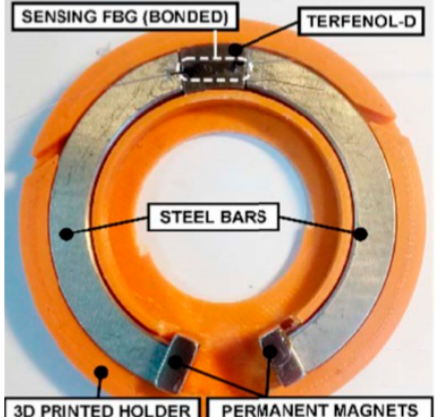
Figure 11. Ring optical fiber current sensor based on 2.0 g magnetostrictive material.